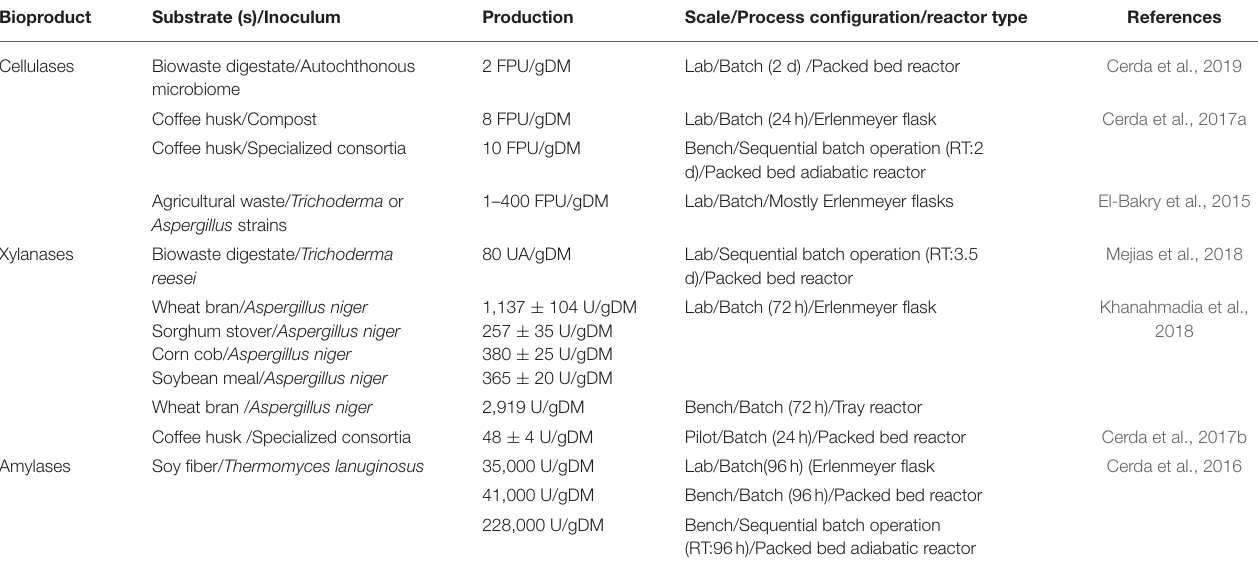
TABLE 1 | Summary of enzymes obtained by solid-state fermentation, production yields and process conditions.